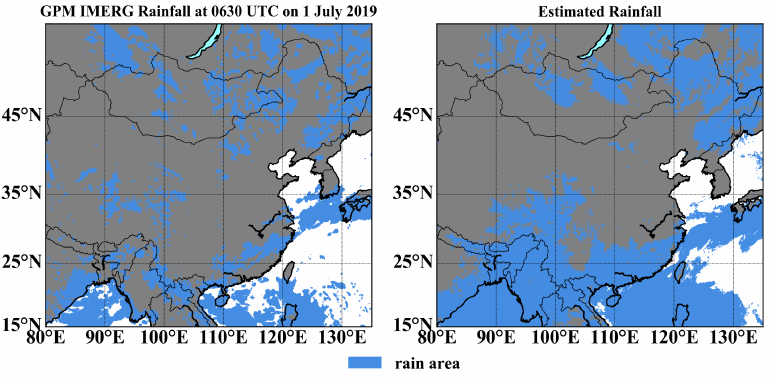
Figure 8. Comparisons of rain area delineation between the GPM ( left ) and RF model ( right ) at 0630 UTC 1 July